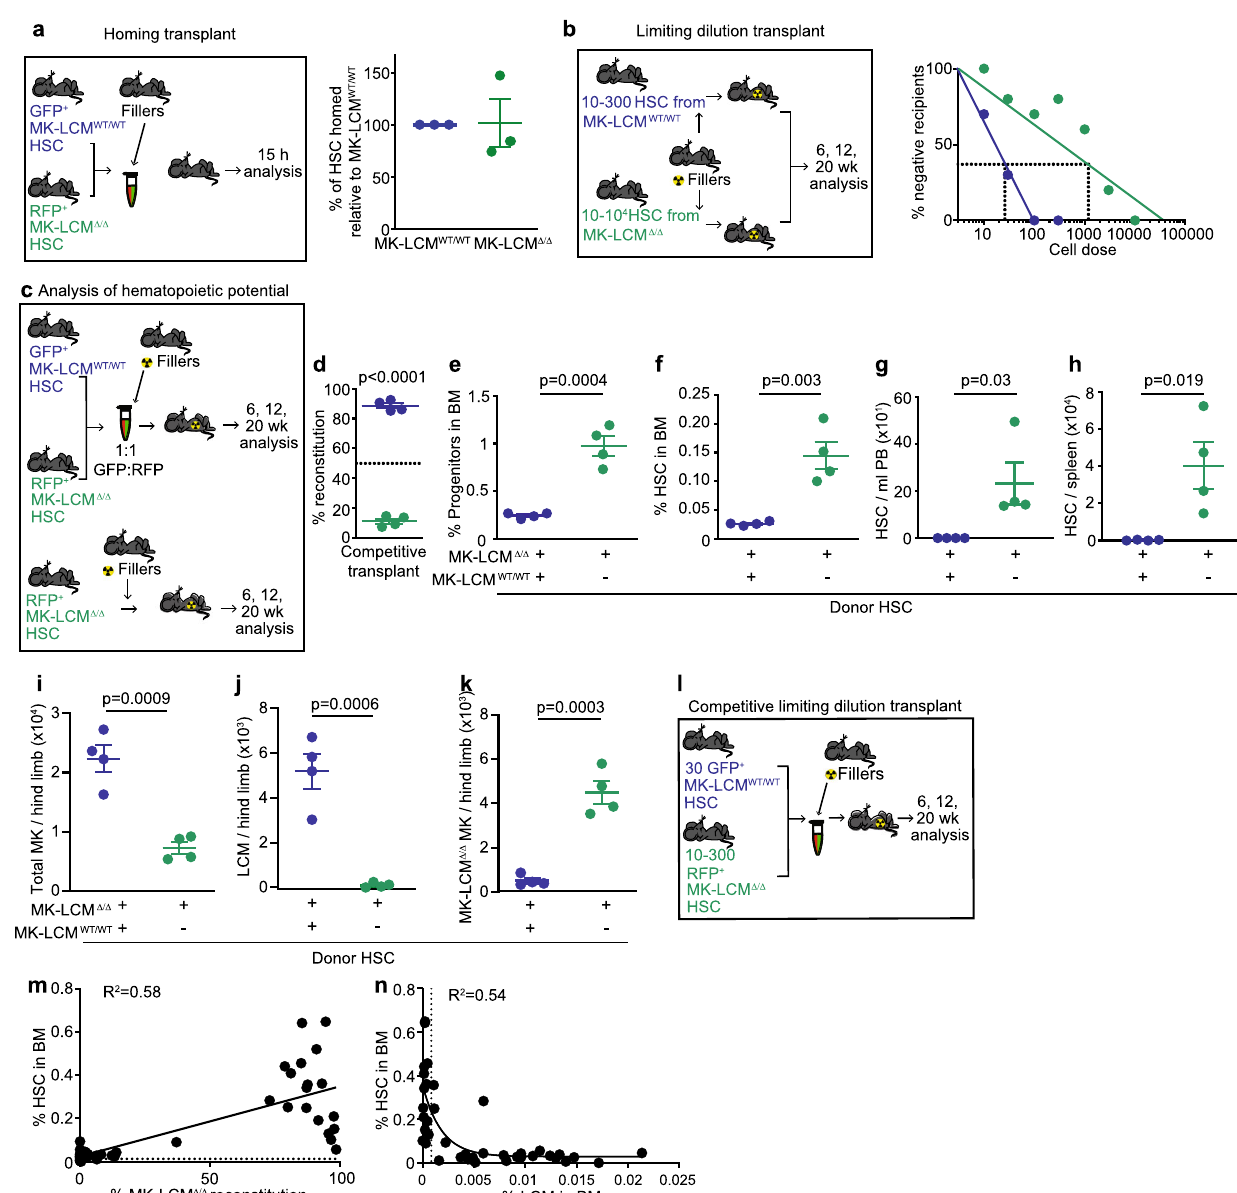
Fig. 4 |DysregulatedHSC poolisrescued byre-establishing BMLCM.a Homing ofMK-LCM WT/WT andMK-LCM Δ / Δ HSCintotheBMofC57Bl/6mice15hpost-transplant ( n =3, biological replicates, from one experiment). b Limiting dilution transplant outcome for mice receiving varying numbers of MK-LCM WT/WT or MK-LCM Δ / Δ HSC ( n =5 for MK-LCM WT/WT cell doses of 100 and 300, n =10 for MK-LCM WT/WT cell doses of 10 and 30, n =5 for MK-LCM Δ / Δ cell doses of 10, 30, 1k, 3k and 10k and n =10 for MK- LCM Δ / Δ cell doses of 100 and 300, all biological replicates, from two experi- ments). c SchematicfortheanalysisofhematopoieticpotentialofGFP + MK-LCM WT/WT plus RFP + MK-LCM Δ / Δ or RFP + MK-LCM Δ / Δ only HSC. d Percentage of donor contribu- tion for a competitive transplant using equal numbers of MK-LCM WT/WT plus MK- LCM Δ / Δ HSC (blue), or MK-LCM Δ / Δ HSC only (green). e Frequency of hematopoietic stem and progenitors and f HSC in mice reconstituted with MK-LCM WT/WT plus MK- LCM Δ / Δ or MK-LCM Δ / Δ only HSC. g The number of HSC in the PB and spleen ( h